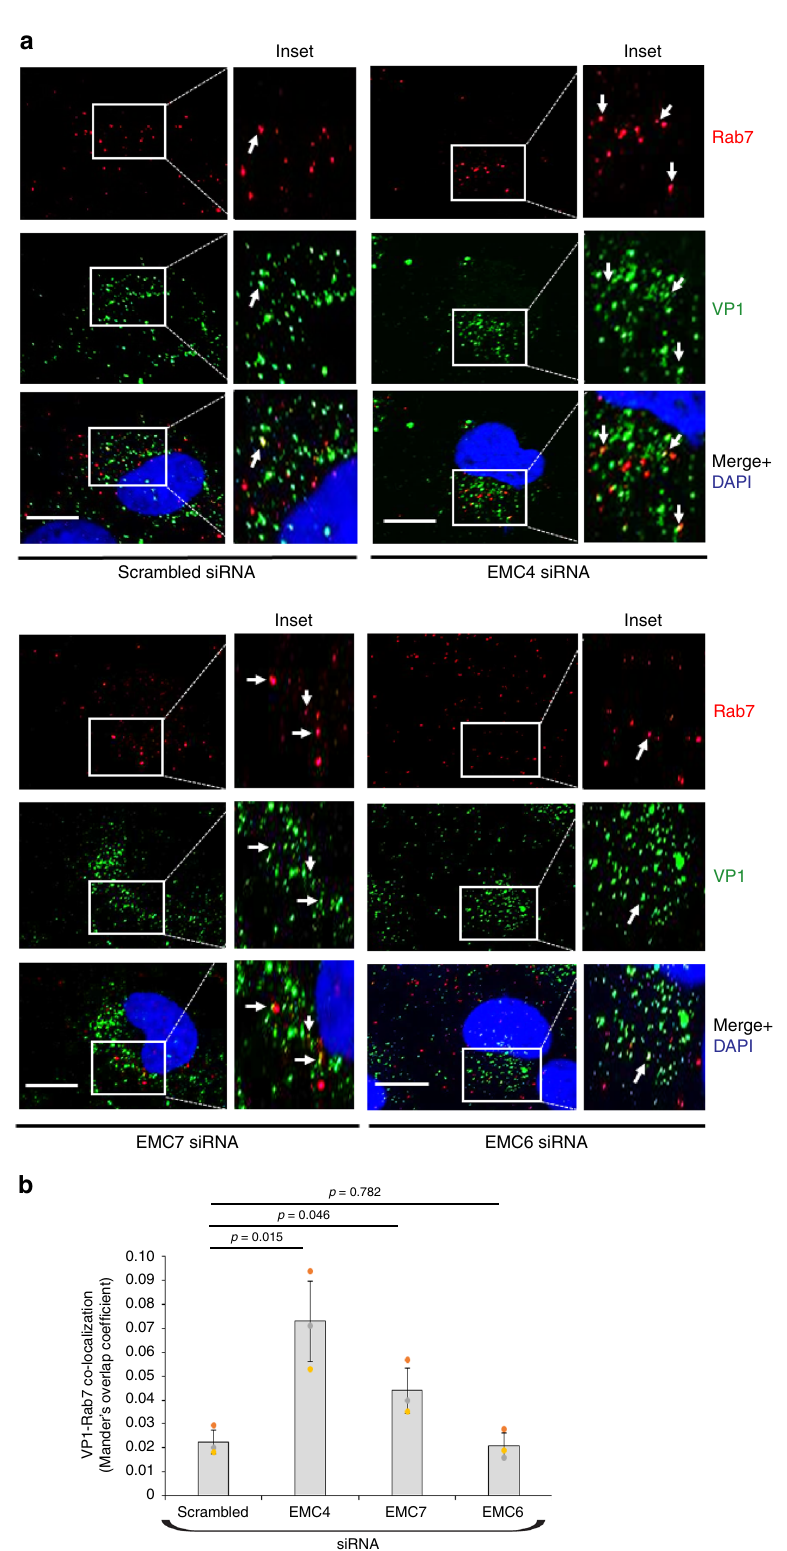
Fig. 3 SV40 accumulates in the late endosome in cells depleted of EMC4 or EMC7. a CV-1 cells transfected with indicated siRNA were infected with SV40 (MOI ~10), fi xed at 6 h post infection, and stained with speci fi c antibodies followed by confocal microscopy. DAPI positions the nucleus. Scale bar = 10 µ m. b VP1-Rab7 colocalization was quanti fi ed as Mander ’ s Overlap Coef fi cient using FIJI/ImageJ coloc2 plugin. The image analysis was done on a single z-plane. Values represent the mean ± SD of three independent experiments and at least fi fty infected cells were analyzed for every conditions during each independent experiments. Unpaired Student two-tailed t -test was used to determine statistical signi fi cance. Source data are provided as a Source Data fi